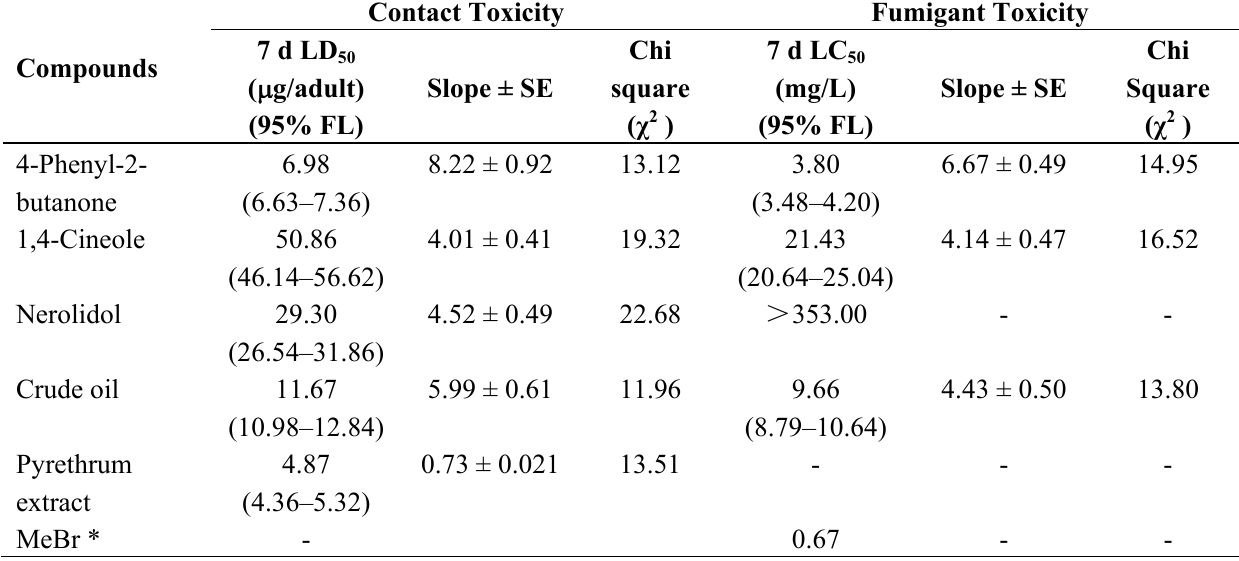
Table 2. Toxicity of compounds isolated from R. anthopogonoides flowering aerial parts against S. zeamais